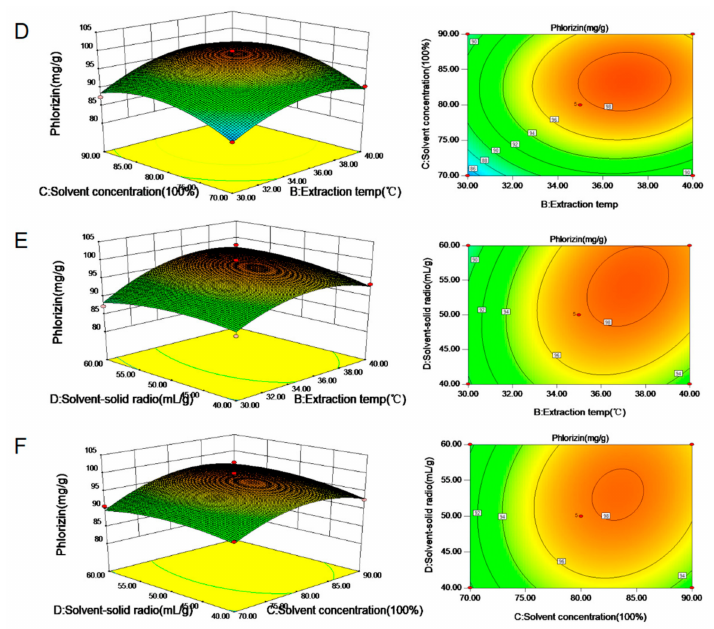
Figure2. Responsesurfaceplots(3D)ofphlorizinanalysisasafunctionofsignificantinteractionbetween factors. ( A ) Extraction temperature and extraction time. ( B ) Solvent concentration and extraction time. ( C ) Solvent-solid radio and extraction time. ( D ) Solvent concentration and extraction temperature. ( E ) Solvent-solid radio and extraction temperature. ( F ) Solvent-solid radio and solvent